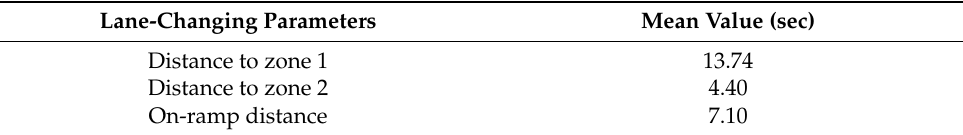
Table 7. Calibrated lane-changing